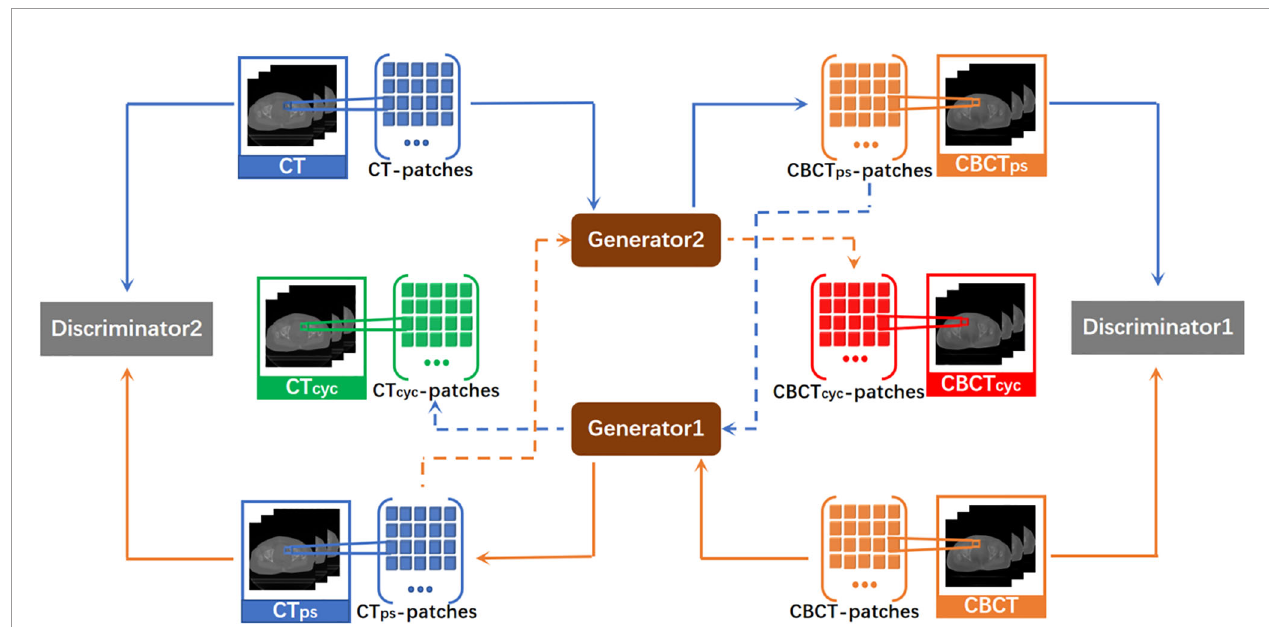
FIGURE 1 | Total network structure of CycleGAN. It is a ring network composed of a GAN from CBCT to CT synthesis direction and a GAN from CT to CBCT synthesis direction. CT ps , pseudo CT obtained by generator1. CBCT ps , pseudo CBCT obtained by generator2. CT cyc , pseudo CT synthesized again through the cycle network. CBCT cyc , pseudo CBCT synthesized again through the cycle